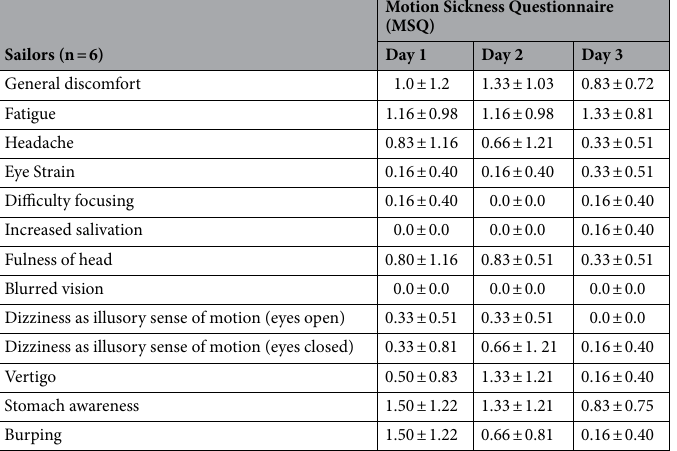
Table 3. Motion Sickness Questionnaire (MSQ). Mean (± SD) values of the investigated variables. Urine standard parameters are reported in Table 4. A significant increase in urinary ketones levels was detected during the navigation. pH and bilirubin values also increased but did not reach statistical